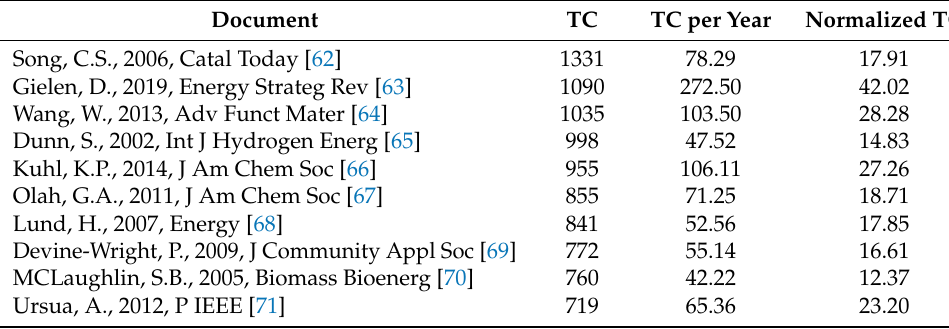
Table 5. Most global cited documents.